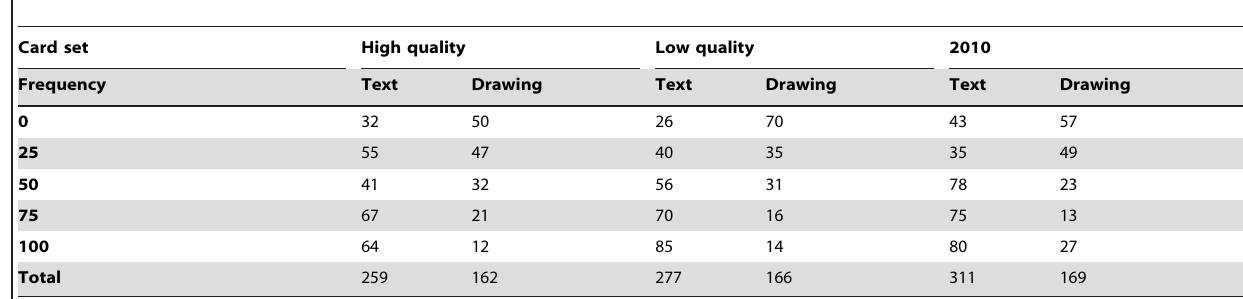
Table 1. Number of cards analyzed for each question and category.